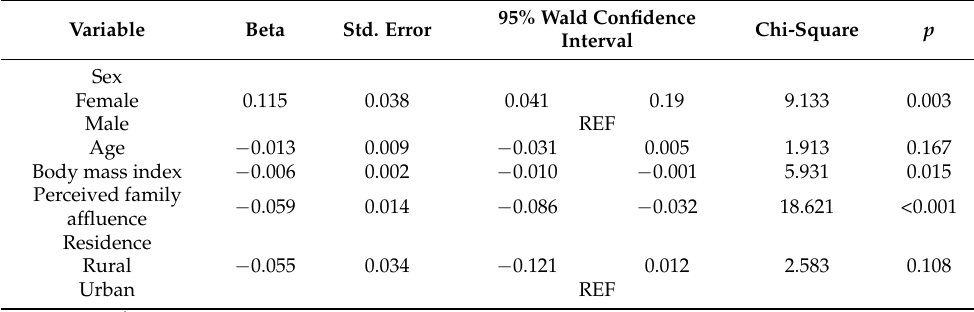
Table 5. Predictors of changes in sedentary behavior during the COVID-19